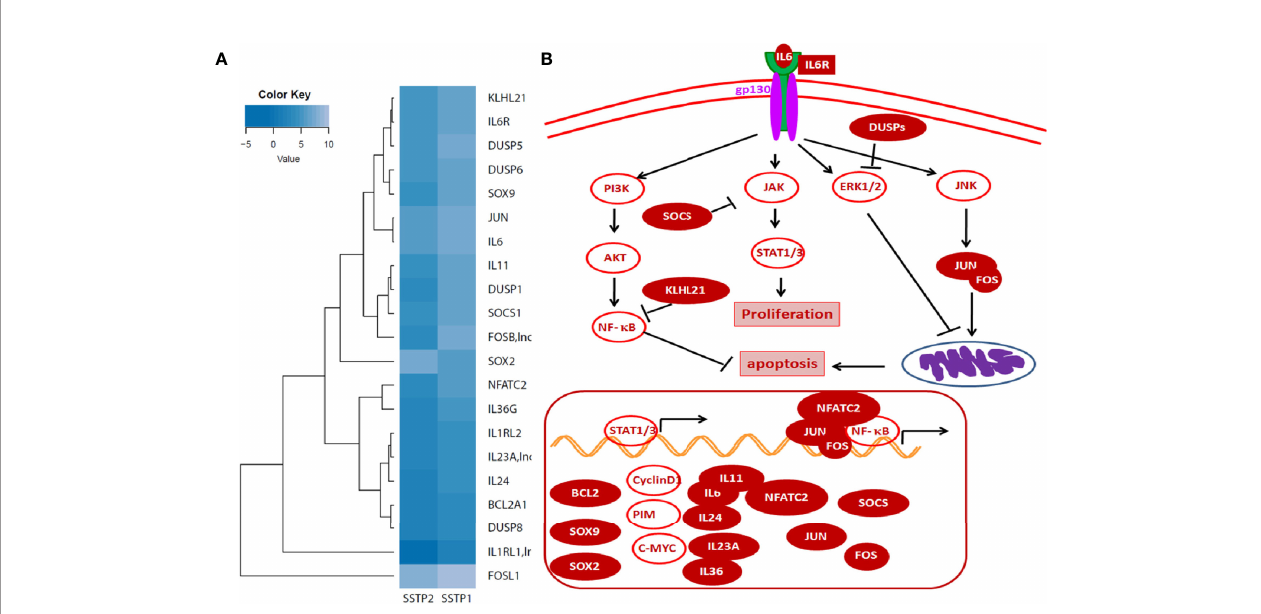
FIGURE 4 | Cytokine signaling pathway involved in SSTP1 response (A) STAT/.JAK, JNK/AP1 MAPK1/2, and AKT pathways are reported to be downstream of Cytokine signaling. Heat map showing differential expression of molecules involved in cytokine signaling are shown. (B) Schematic diagram of cytokine signaling pathway in SSTP1